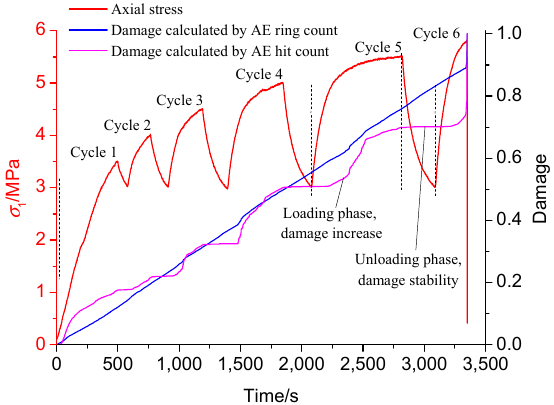
Figure 10. Damage evolution curves.